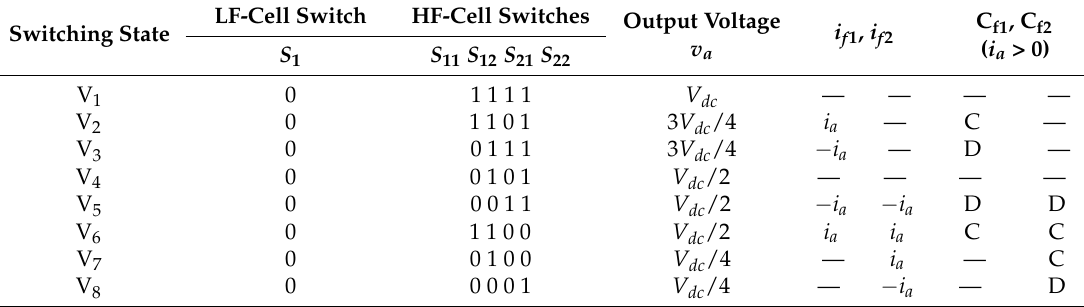
Figure 26. Single-phase 9L HSM converter connected with RL -load. Figure 26. Single ‐ phase 9L HSM converter connected with RL ‐ load. Table 8. Operation of 9L HSM Table 8. Operation of 9L HSM converter.